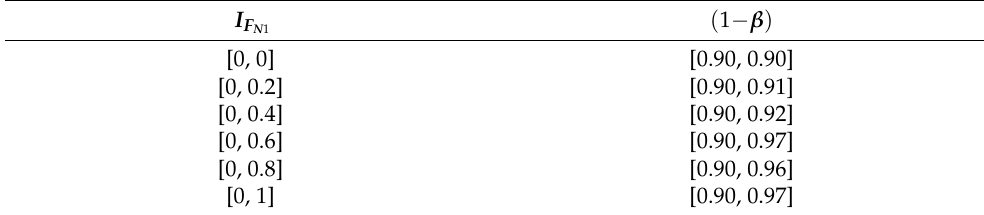
Table 4. The values of the power of the test when α =